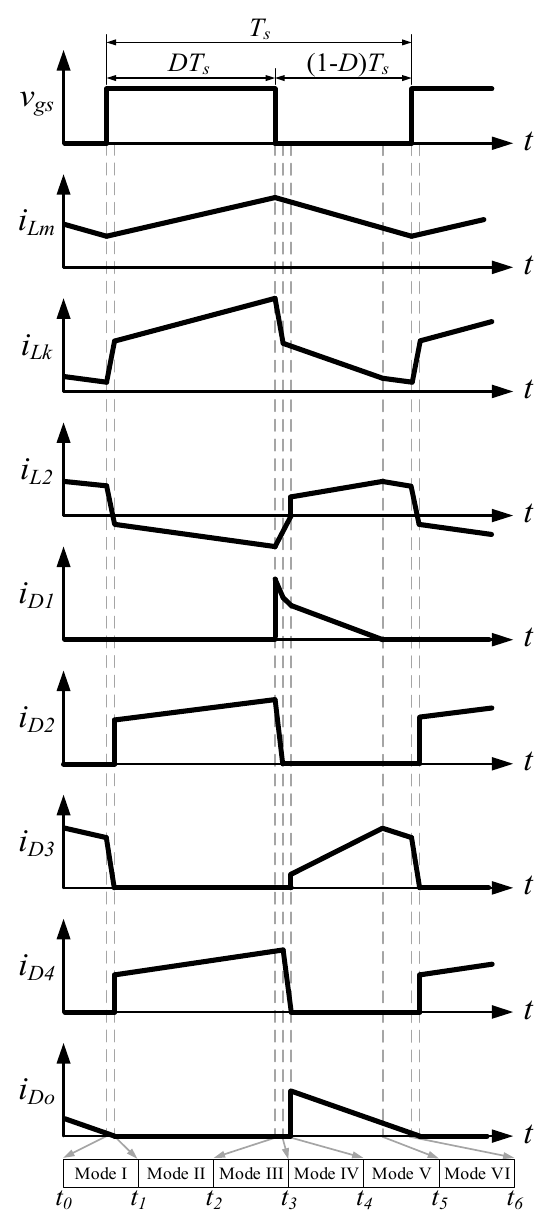
Figure 5. Conceptual key waveforms of the proposed